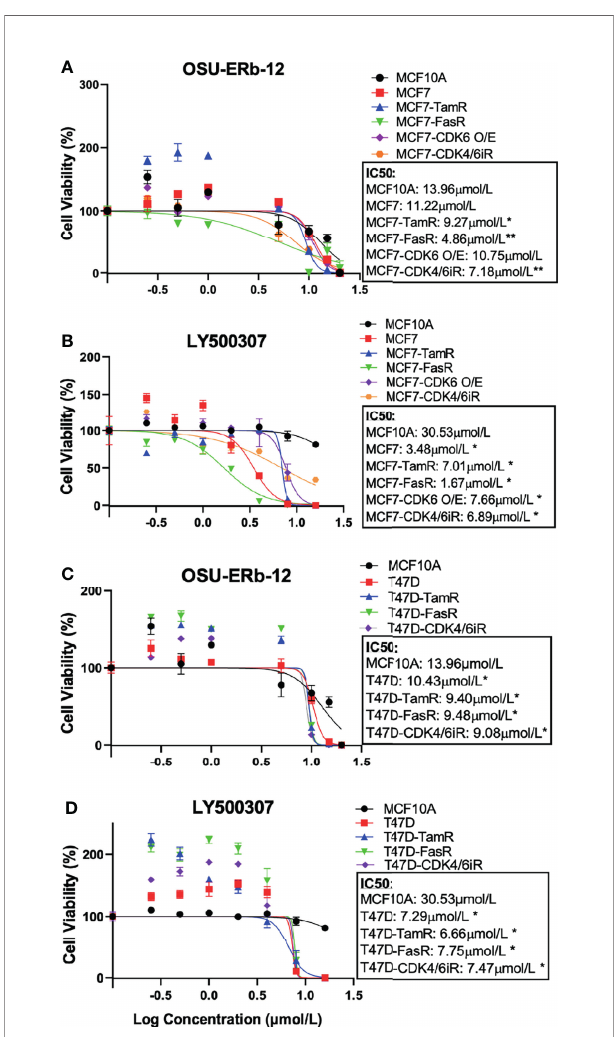
FIGURE 2 | Selective ER b agonists demonstrate signi fi cant cytotoxicity in ER a + parental and respective endocrine-resistant breast cancer cell lines. Cytotoxicity assays were performed on immortalized MCF10A, ER-positive MCF7 and T47D, endocrine-resistant MCF7 and T47D, CDK4/6 inhibitor- resistant MCF7 and T47D, and CDK6 overexpressing MCF7 (MCF7-CDK6 O/E) cells. Viable cells were measured after 7 days of treatment with DMSO (control) or the drugs at the indicated concentrations using CellTiterGlo assay. The percentage of viable cells is shown relative to DMSO vehicle-treated controls (mean ± SD, *p < 0.05, **p < 0.01). Assays were performed in quadruplicates (three experimental replicates). Cell viability assay performed after treatment with (A, C) OSU-ERb-12 and (B, D) LY500307. TamR, tamoxifen resistant; FasR, fulvestrant resistant; CDK6 O/E, CDK6 overexpressing; CDK4/6iR, CDK4/6 inhibitor resistant; MPP,